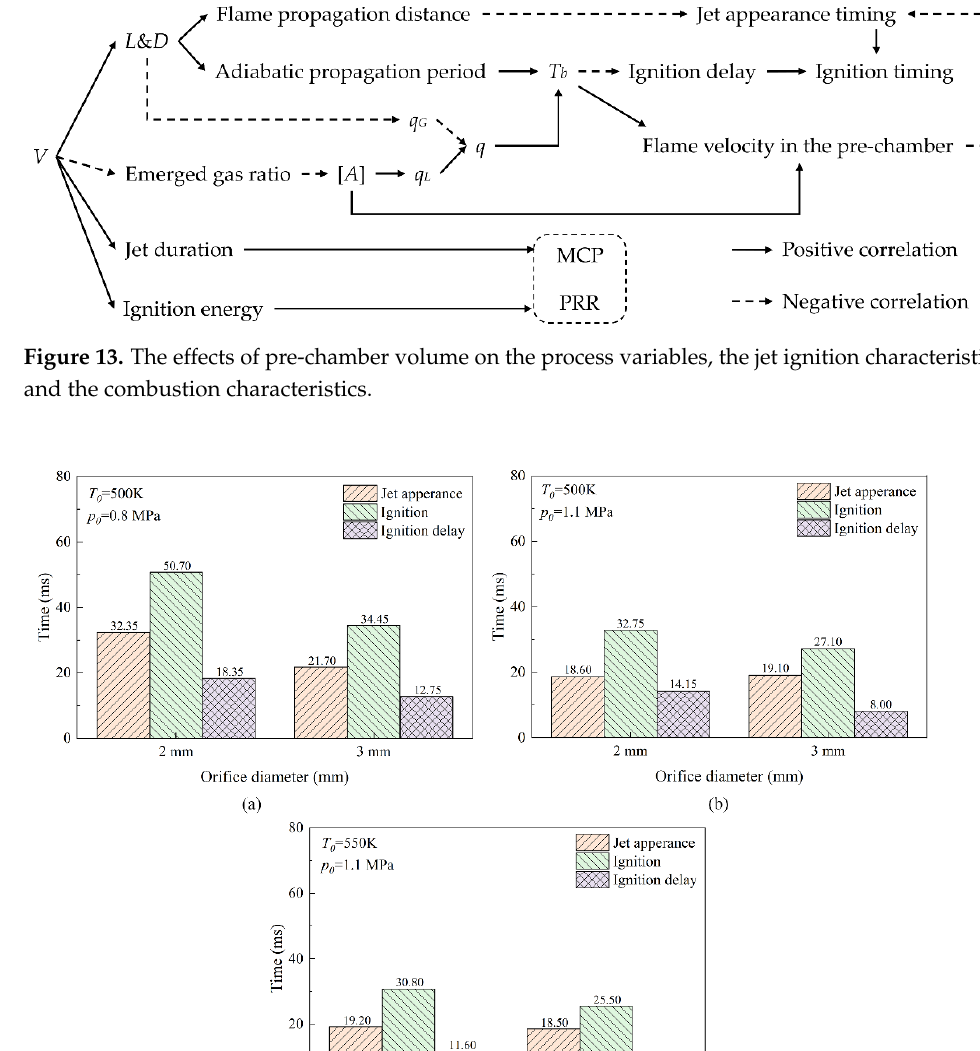
Figure 12. Pressure and pressure rise rate traces in the main chamber for different pre-chamber vol- umes under different initial thermodynamic parameters.